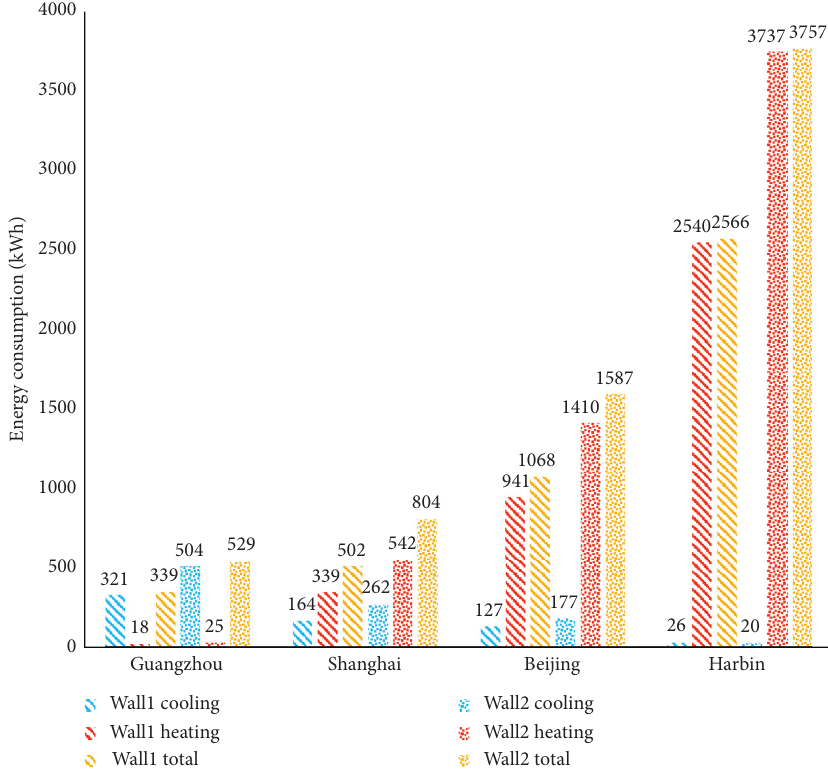
Figure 10: Comparison of annual energy consumption of the two walls in four